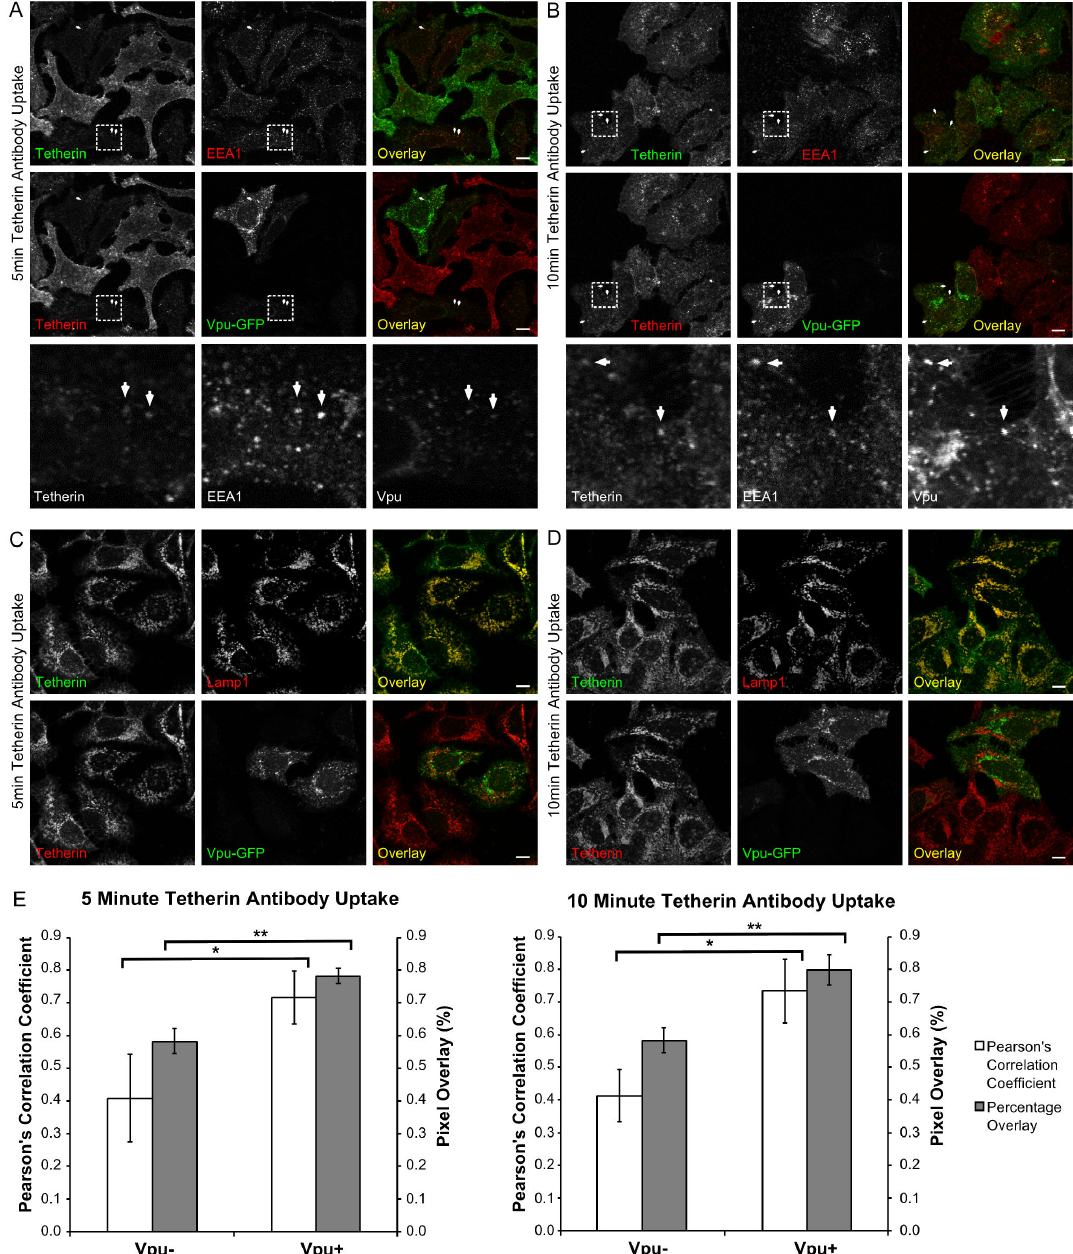
Figure 5. Immunolocalisation of internalized tetherin in the presence and absence of Vpu. A - D . HeLa cells that had been transiently transfected to express Vpu-GFP and which had been incubated in the presence of lysosomal enzyme inhibitors for 24 hours were incubated at 4°C for 60 min with a monoclonal antibody (HM1.24) that recognises the extracellular domain of tetherin. Cells were then transferred to 37°C for various times and processed for immunofluorescence analysis using polyclonal antibodies to markers of early (EEA-1, A, B ) or late (LAMP-1, C, D ) endosomes. Some of the internalised tetherin can be seen to colocalise with both Vpu and EEA1 after 5 ( A ) or 10 ( B ) min at 37°C (see white arrows; bottom sets of panels represent magnifications of the boxed regions from the corresponding images above and are 20µ 2 ); however, there is greater evidence of colocalisation between internalized tetherin and LAMP-1 at both time points ( C and D ). This is quantified by Pearson’s correlation coefficient (PCC) and percentage pixel overlay (%O) in E . This co-localisation is greatest in cells that also express Vpu at both 5min (PCC P=0.027, %O P=0.0015 n=3) and 10min (PCC P=0.0117, %O P=0.0034 n=3) antibody uptake. It is of note that there is limited evidence of any co- localisation between Vpu and LAMP-1 ( C and D ). Bar = 10µ. doi: 10.1371/journal.pone.0075680.g005 PLOS ONE |